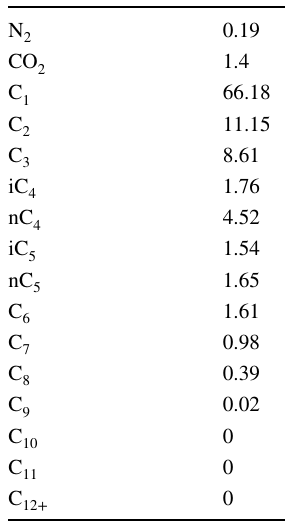
Table 5 Composition of the injected APG into the reservoir